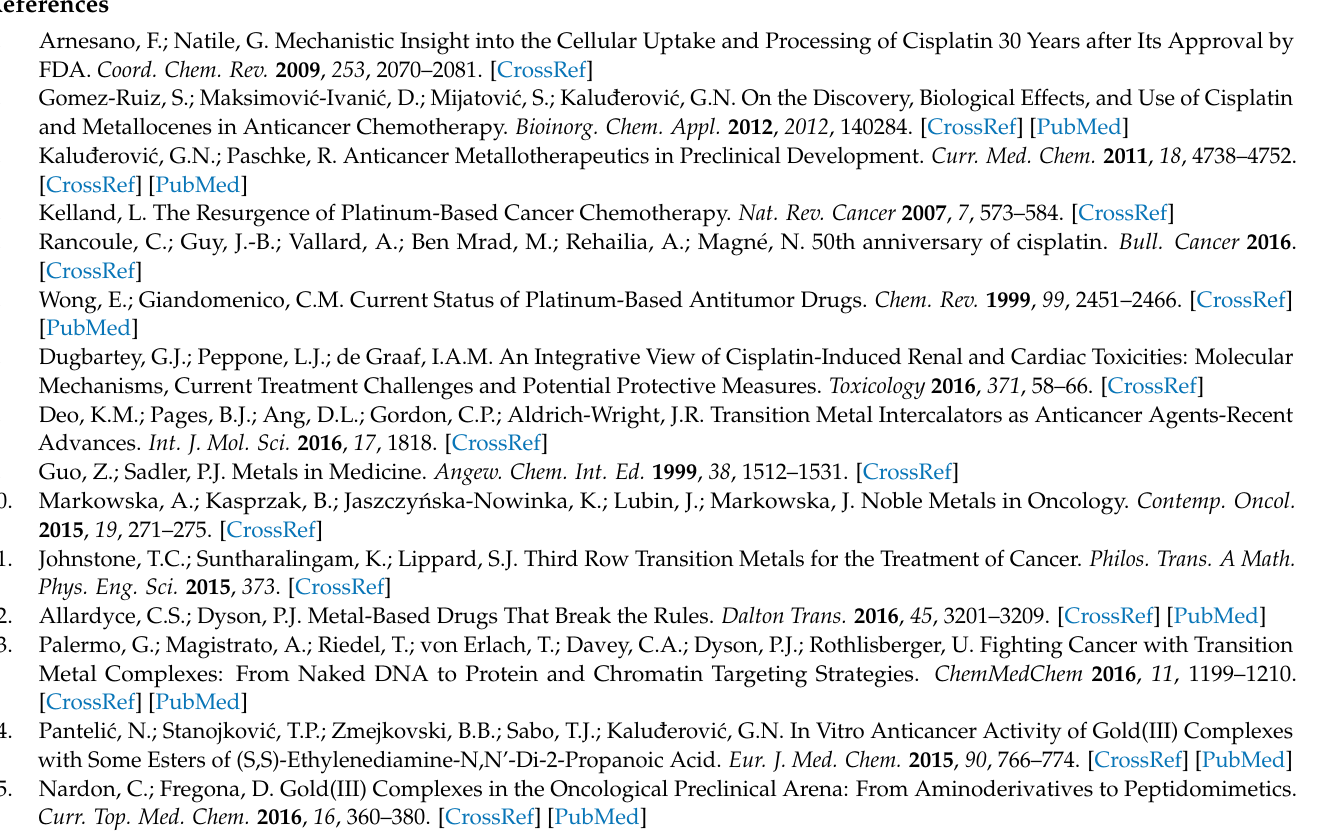
Figure S5: [Ru( η 6 -thn)Cl 2 {Ph 2 P(CH 2 ) 3 SPh- κ P }] 2d , Figure S6: [Ru( η 6-thn)Cl{Ph 2 P(CH 2 ) 3 SPh- κ P , κ S }]- PF 6 4d , Figure S7: [Ru( η 6 -mesitylene)Cl{Ph 2 P(CH 2 ) 3 SPh- κ P , κ S }]Cl 3b , Figure S8: [Ru( η 6 -mesitylene)- Figure S10: [Ru( η 6 -1,4-dialin)Cl{ Ph 2 P(CH 2 ) 3 SPh- κ P, κ S }]PF 6 4e